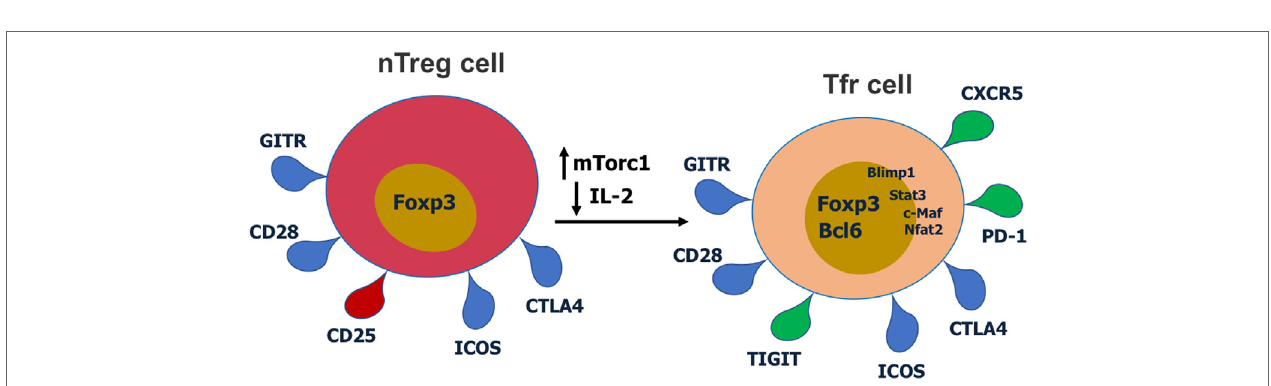
FiGURe 2 | Cell surface receptors and transcription factors involved in T follicular regulatory (Tfr) cell differentiation and function. Red receptors are downregulated and green receptors are upregulated during Tfr cell differentiation.